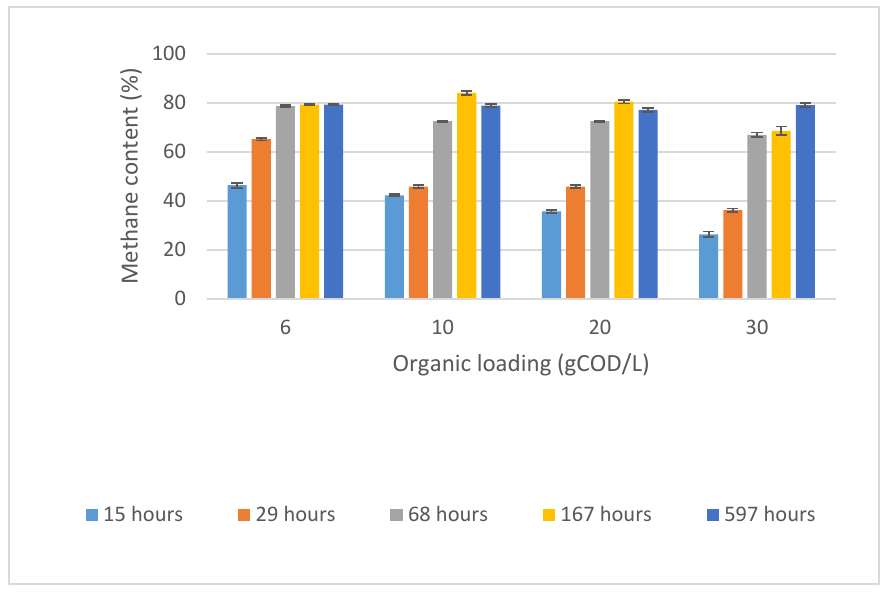
Figure 6. Methane content of H140 at different OLs over time in syringes. Table 9. Weighted average methane content in the produced biogas in syringes.